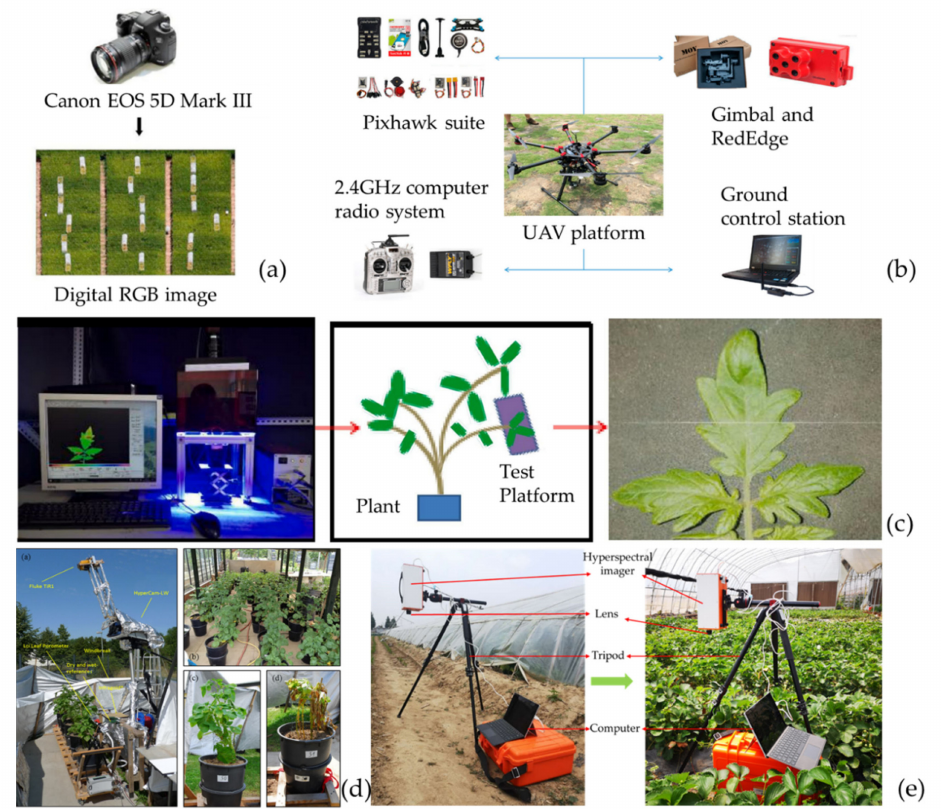
Figure 1. Typical optical sensors used for plant stress detection. ( a ) Digital sensor for maize heat stress [3]; ( b ) multispectral imaging sensor for maize water stress [4]; ( c ) fluorescence imaging sensor for chilling injury of tomato seedlings [5]; ( d ) thermal imaging sensor for potato water stress [6], and ( e ) hyperspectral imaging sensor for apple water stress